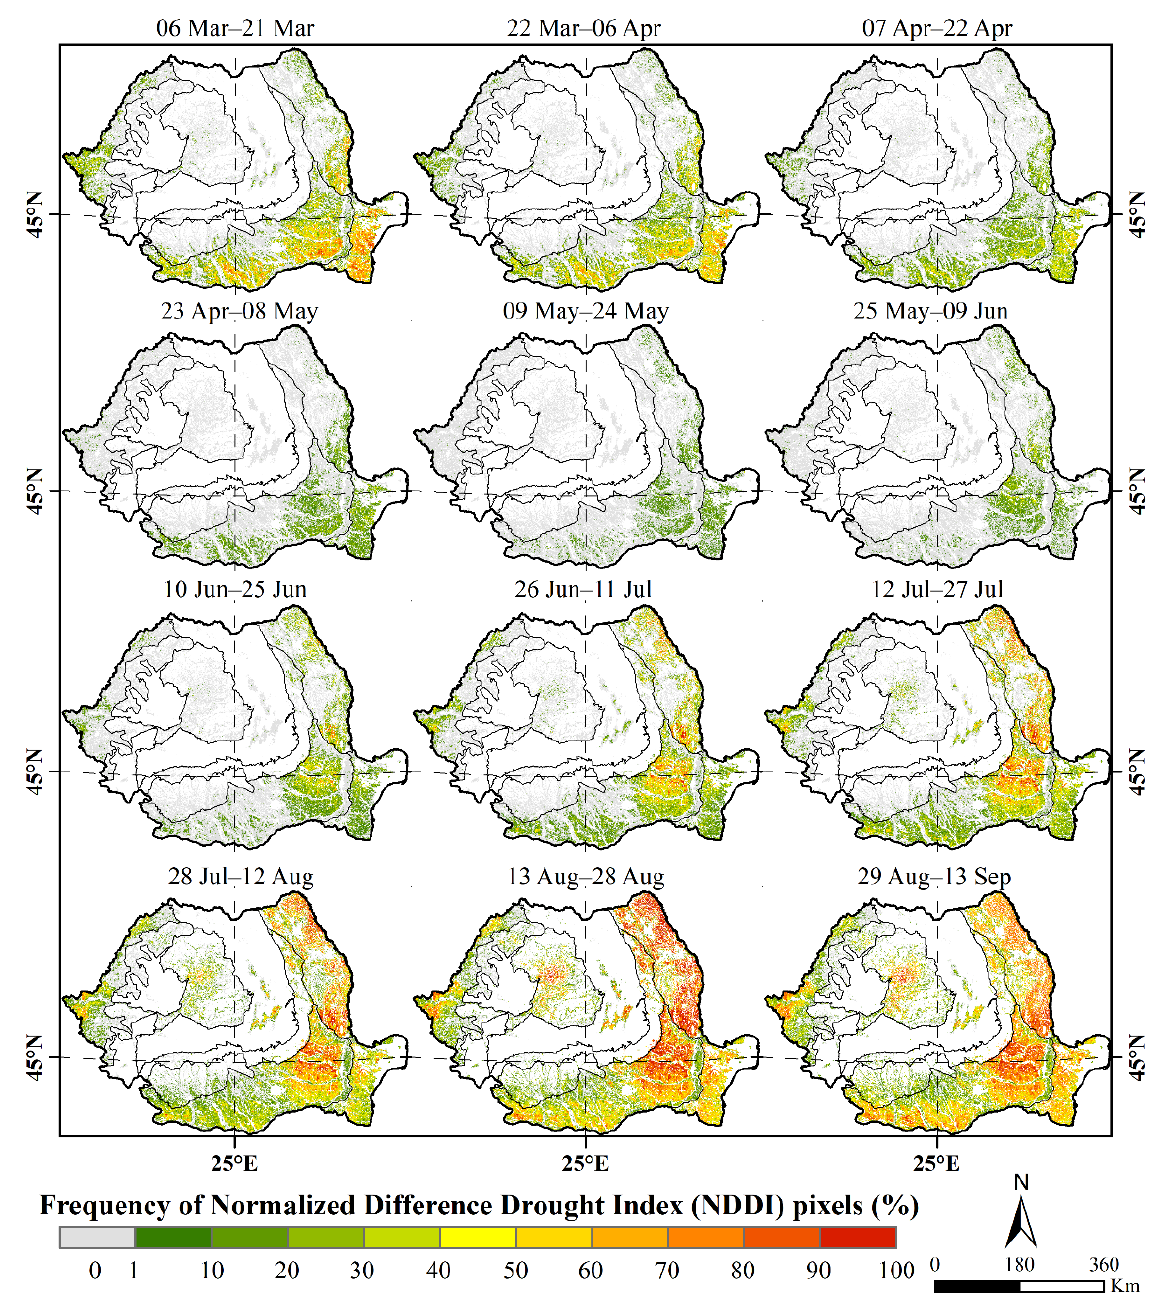
Figure 3. Spatial relative frequency of drought classes (NDDI >0.5) at the level of arable lands in Romania for the 16-day composite periods between March and September (2001–2020).